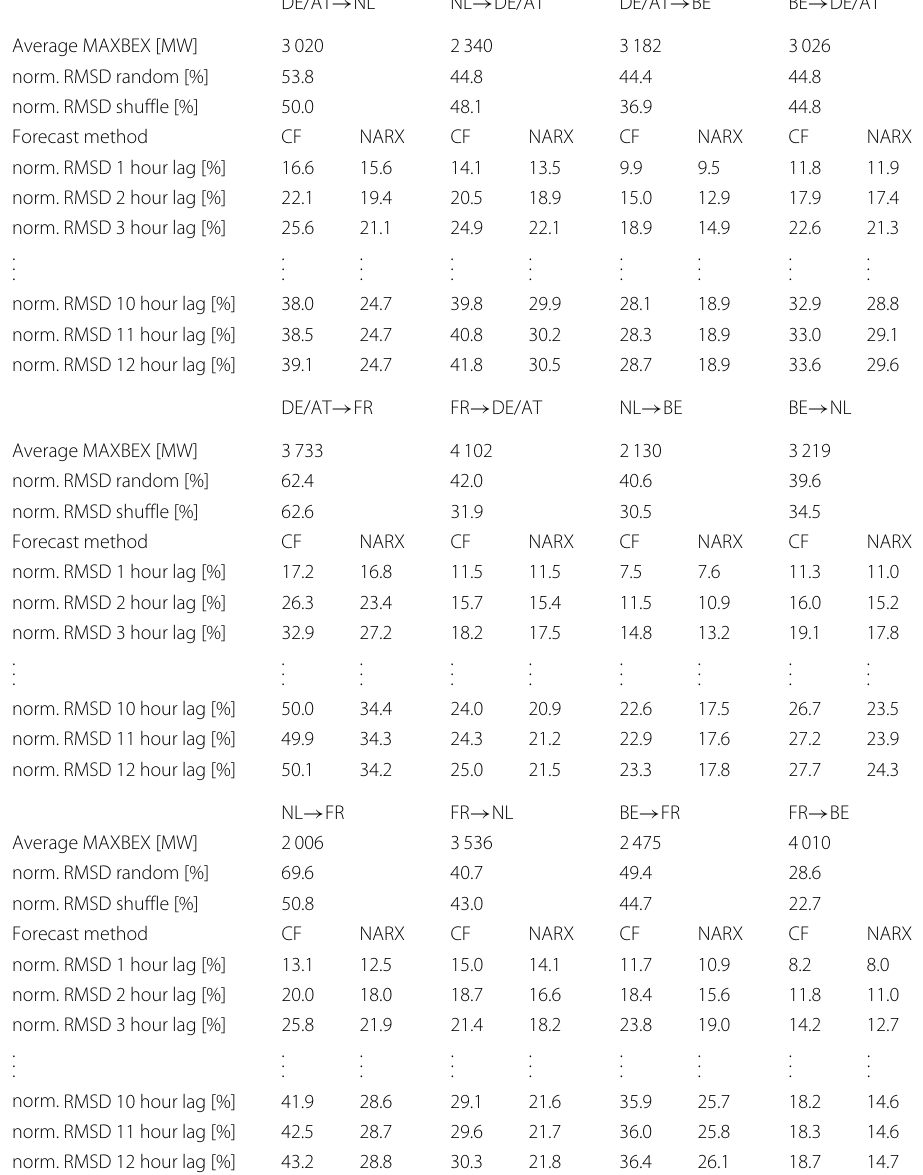
countries, normalized by the average MAXBEX DE/AT → NL NL →